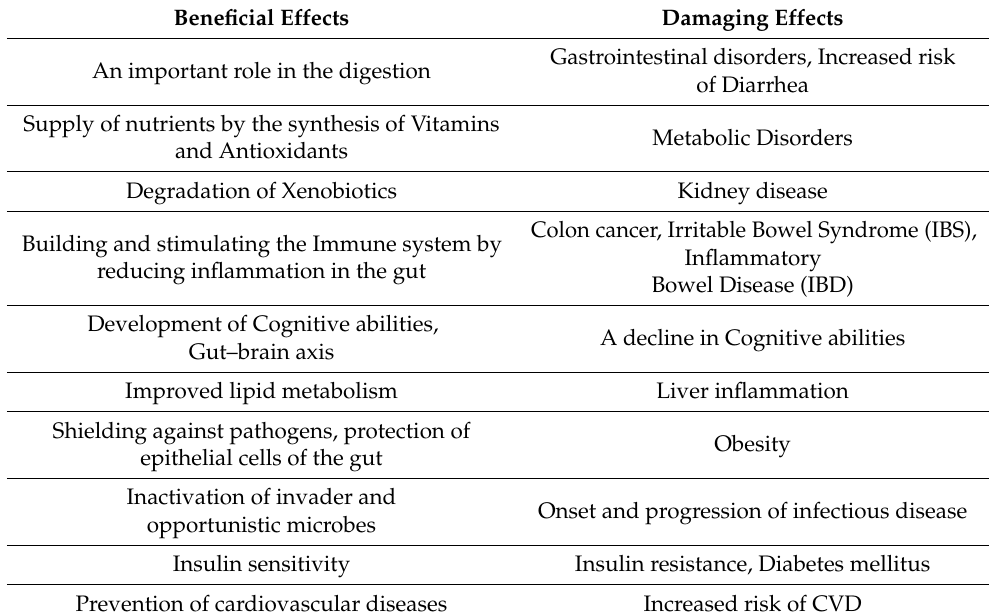
Table 1. Role of the Gut Microbiota in Health and Disease [1–7] (table drawn by us, information collated from several